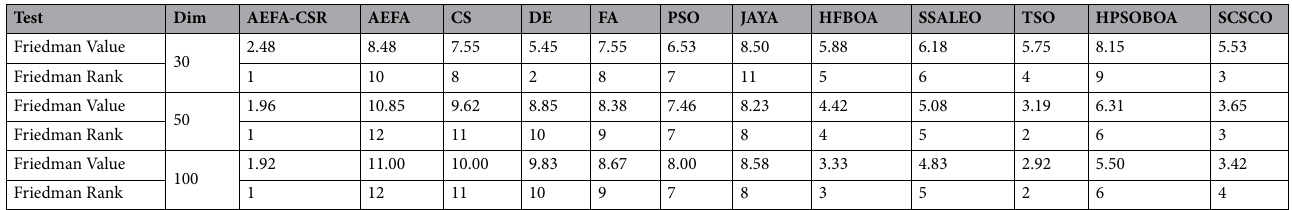
Table 8. Friedman’s test for dimension 30 , 50 and 100 dimensions for 20